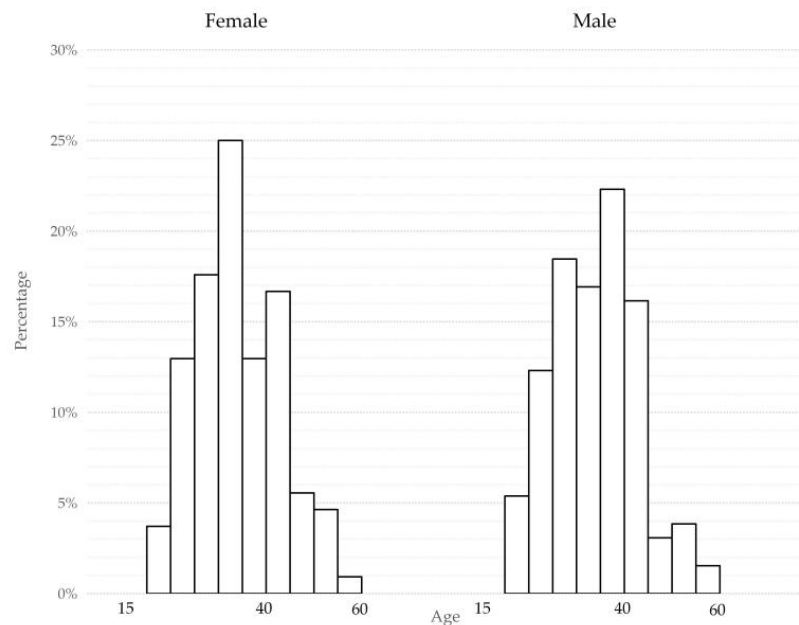
Figure 2. Age and gender distribution of the respondents.